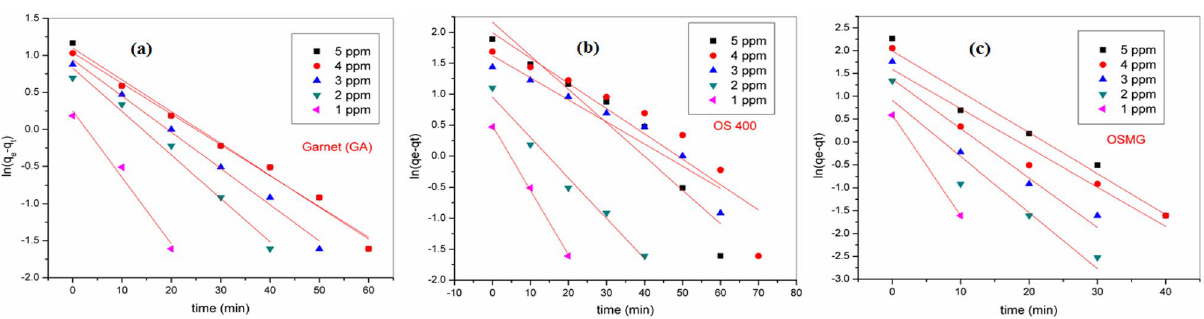
Figure 11. Pseudo-first-order kinetics for adsorption of MB dye onto ( a ) GA, ( b ) OS400 and ( c ) OSMG.